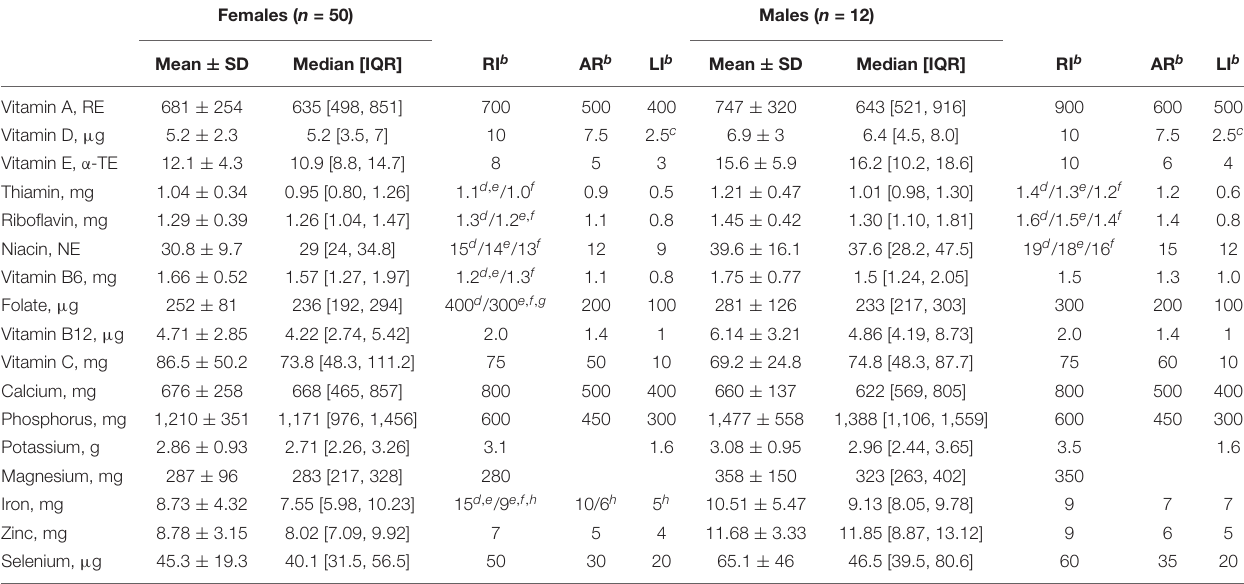
TABLE 3 | Micronutrient intake in patients with rheumatoid arthritis residing in southwestern Sweden a . Females ( n = 50) Males ( n = 12)